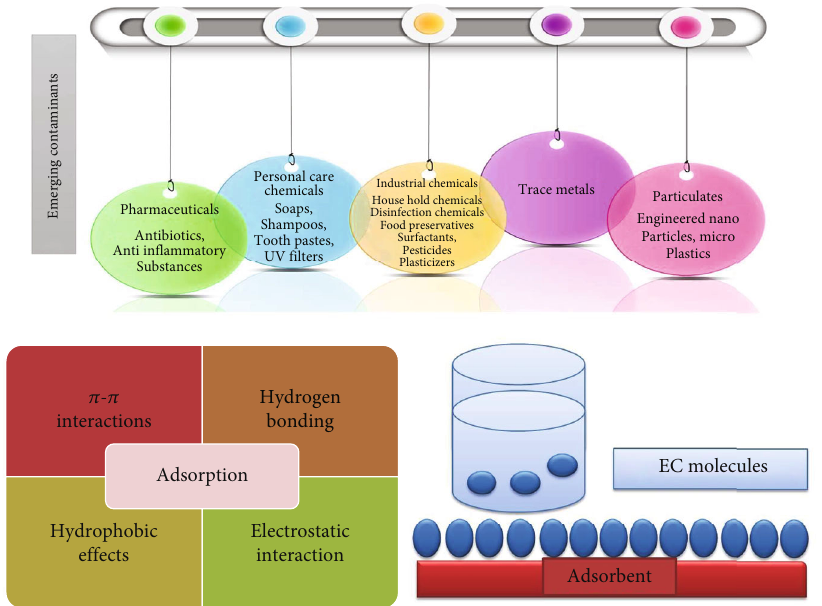
Figure 2: Overview of EC